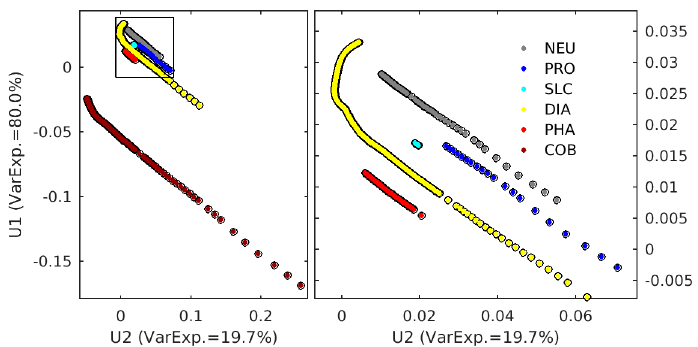
Figure 12. The fitted orthogonal models (first U 1 and second U 2 modes) for each PFT. The section on the right is an enlargement of the square area in the section on the left. Abbreviations are the same as in Figure 5.